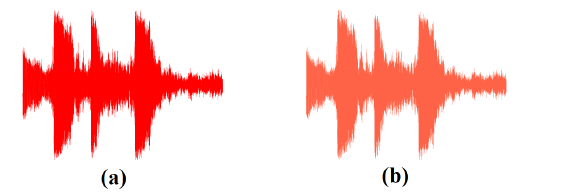
Figure 14. The original audio before publish. ( a ) left channel, ( b ) right channel.